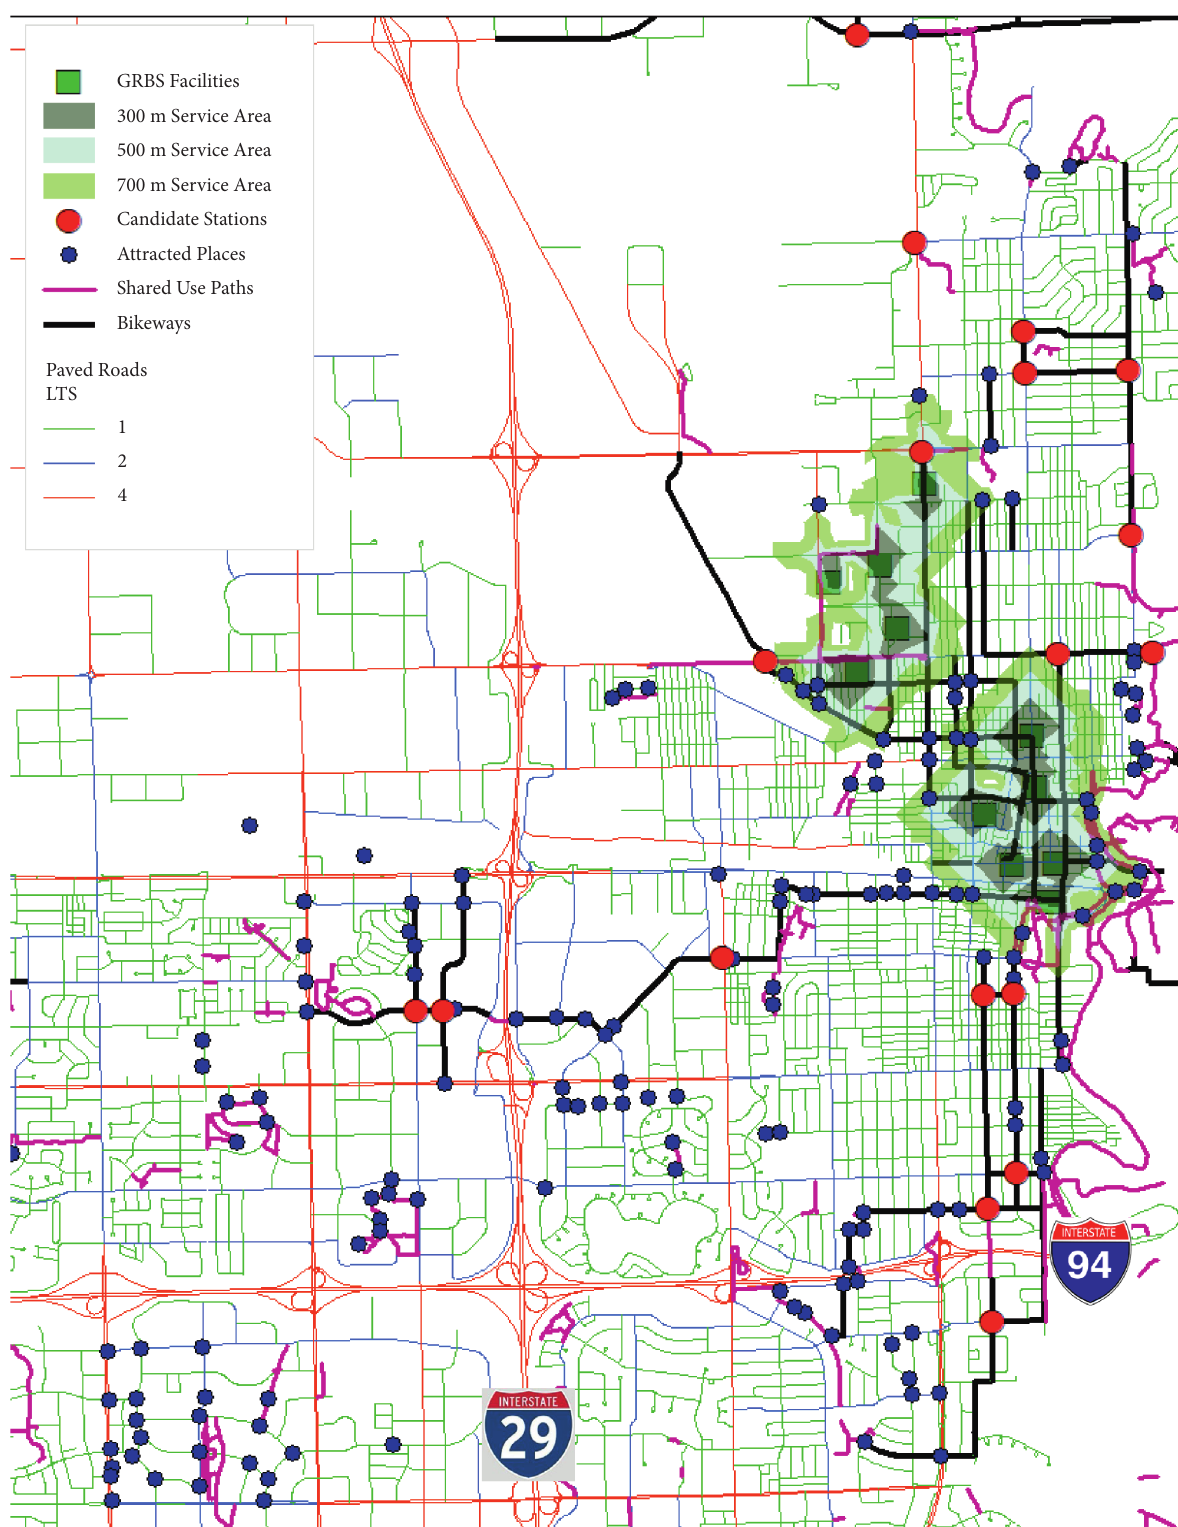
Figure 3: LTS ratings for pathways in Fargo, North